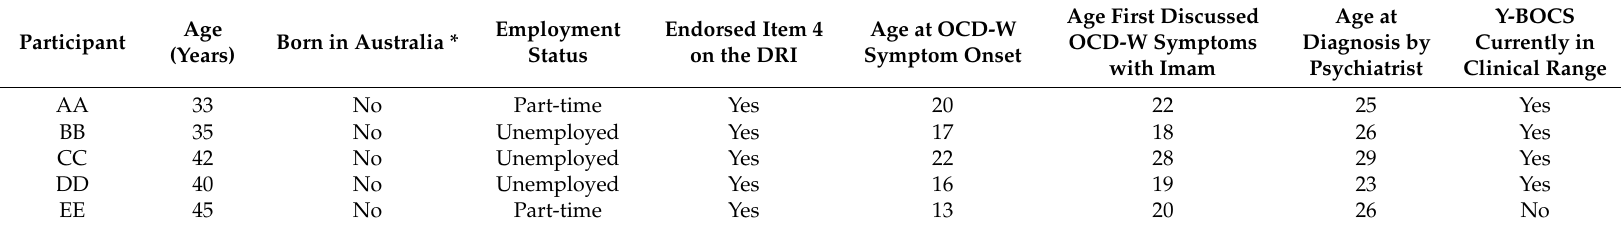
Table 1. Characteristics of